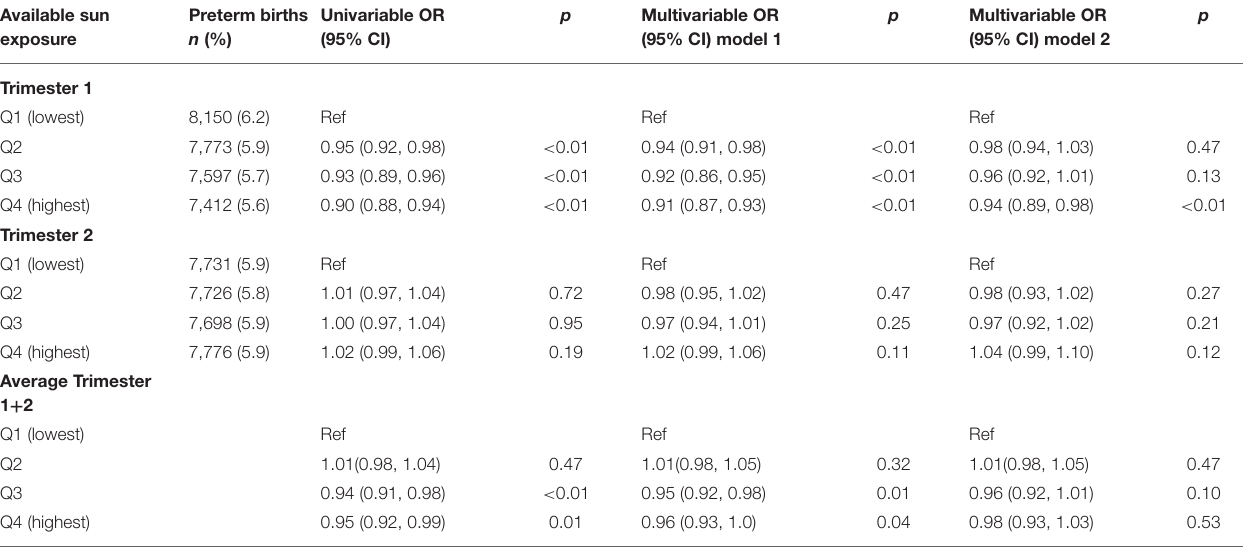
TABLE 2 | Association between mean quartile of sun hours available per day in trimester 1, trimester 2 and the combined average exposure over trimester 1 and 2, and preterm birth in Scotland 2000–2010 using logistic regression. Available sun exposure